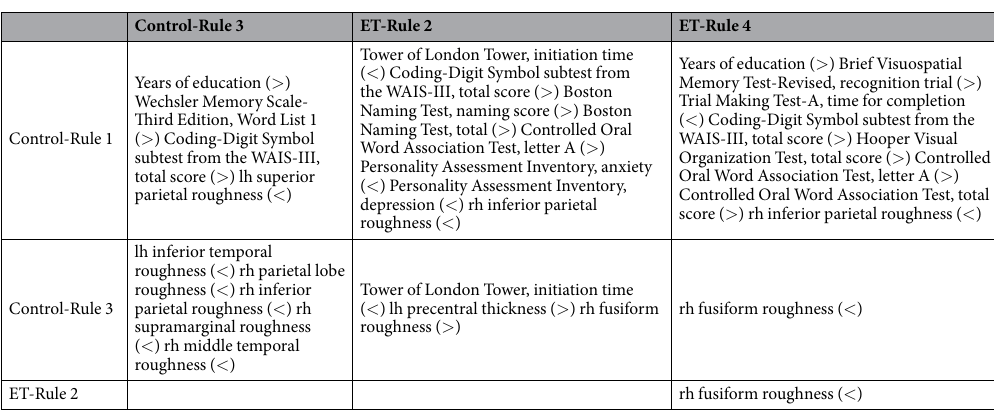
To assess the possible correlations of these groups with cognitive function, Table 6 presents the scores from the neuropsychological tests performed that presented statistically significant differences among the groups defined by the rules. While all of the tests delineated in the Methods section were included in this analysis, this table includes only those that demonstrated statistically significant differences among any pair of rule-based groups. Structurally, Table 7 shows the features that presented statistically significant differences between the groups defined by the rules. Table 8 summarizes the cognitive and structural differences between each pair of groups of subjects defined by the rules, which presented statistical significance. The rule model showed that ET patients were distinguished from healthy controls in two different groups (rules 2 and 4). This division is interesting because it might be pointing to clinical subtypes of ET. The structural areas, whose roughness significantly differentiated conditions and the two ET groups, are depicted in Fig. 6 according to the Desikan-Killiany Atlas used. According to Table 8, the two groups of ET defined by the rule model only presented significant differences in the roughness of the right fusiform cortex (Brodmann areas 20 and 37). Since there were no significant differ- ences between the two ET groups in neuropsychological terms (data not shown), the structural difference might account for clinical subtyping. However, no significant difference regarding disease duration or disease severity was found between the two groups, as shown in Table 9.